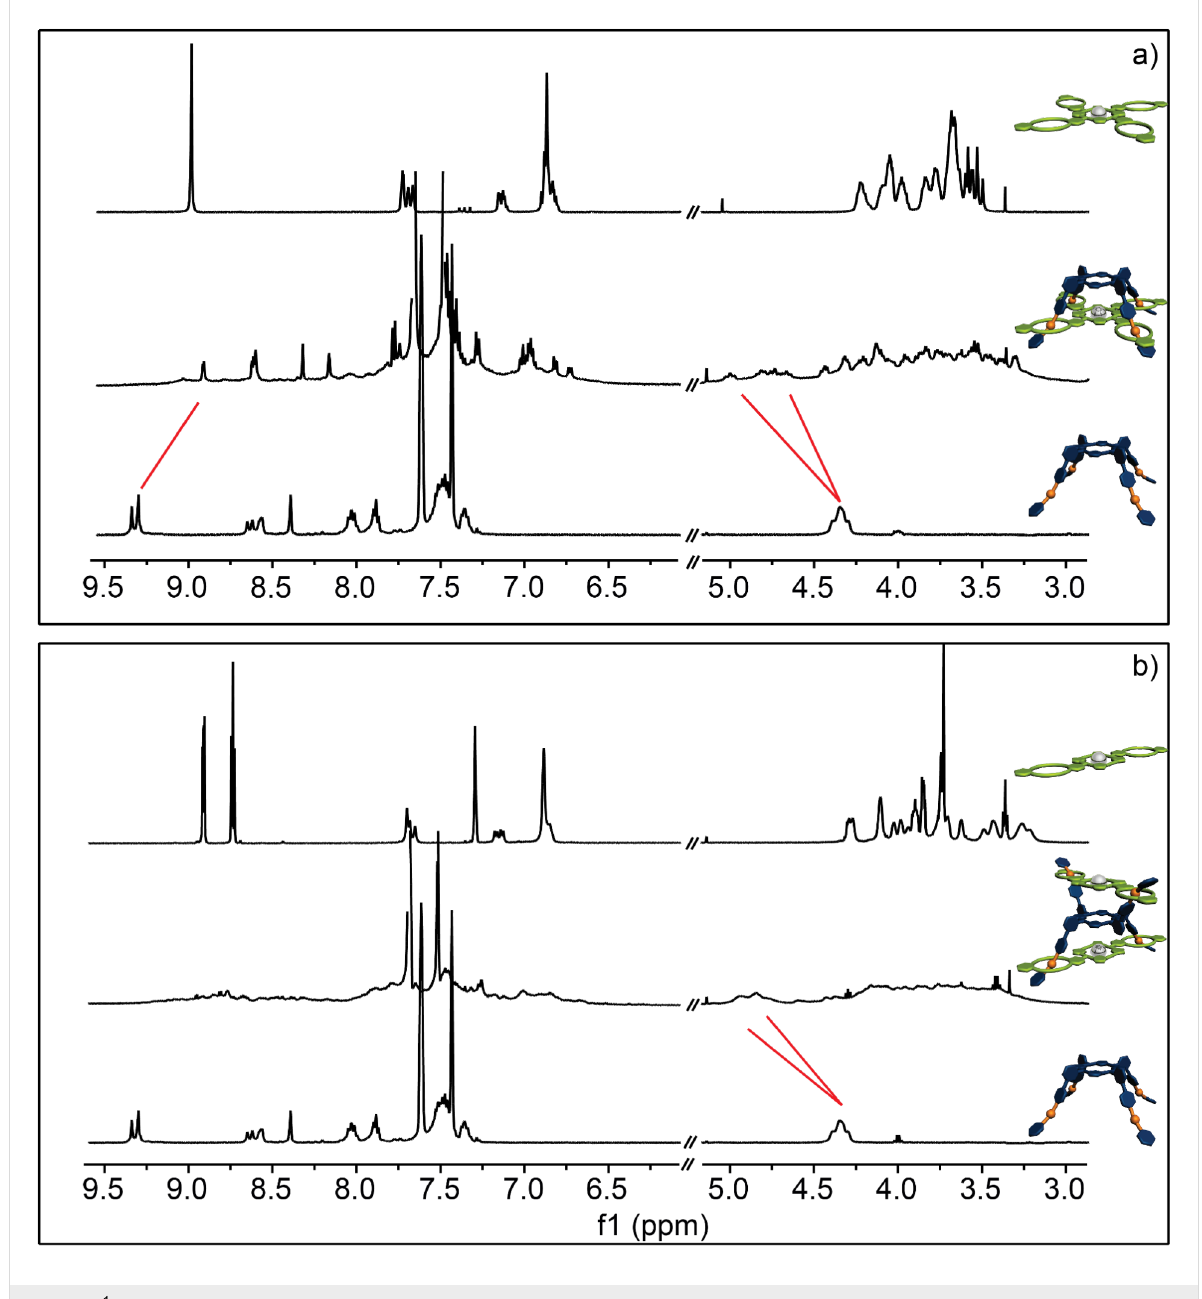
Figure 8: 1 H NMR (500 MHz, 298 K, CD 2 Cl 2 , 1 mM) of a) C4 (top), A4 @ C4 (middle) and A4 (bottom) and b) C2 (top), A4 @ C2 2 (middle) and A4 (bottom). Disappearance and shift of the signals (red lines) suggest complexation. Due to the presence of a complex stereoisomeric mixture only qualitative information of the complexation is